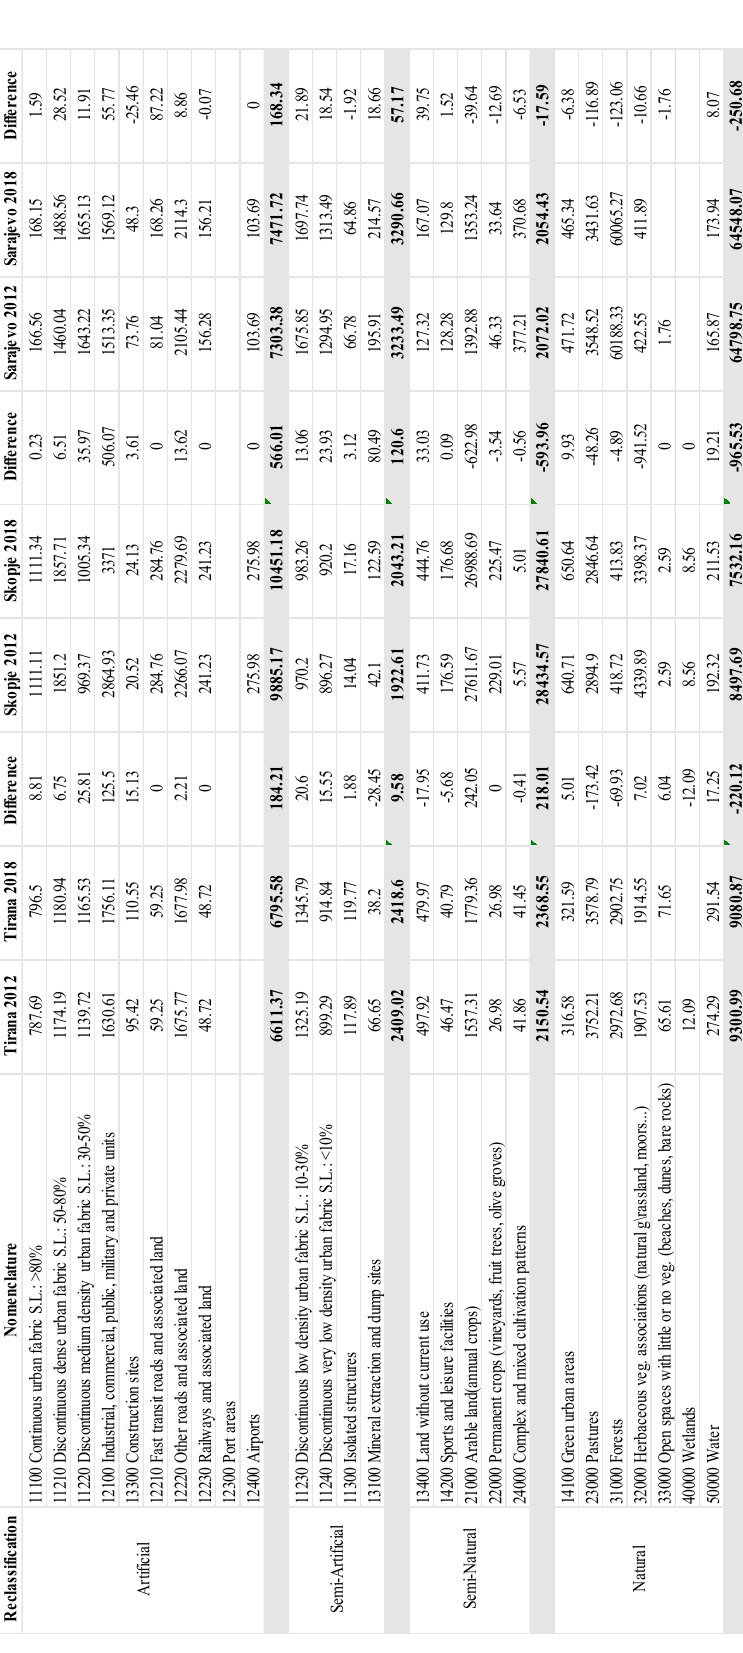
Figure A4. Each city’s ha results for 2012–2018 and their difference values.